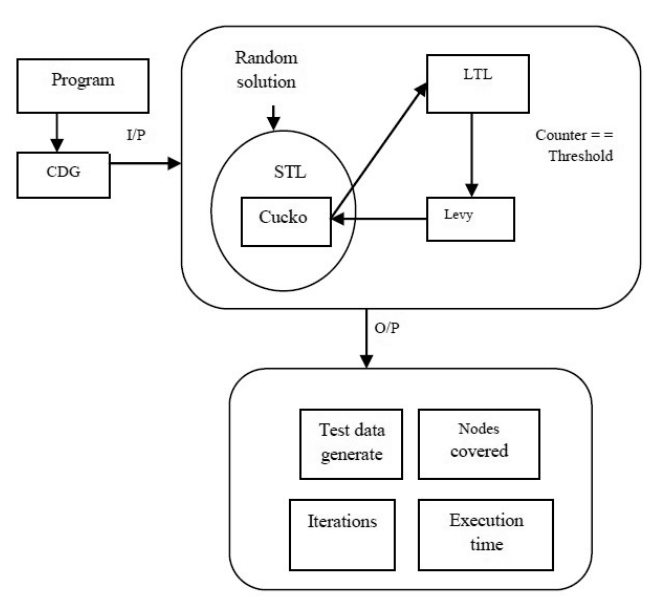
Figure 1. Software